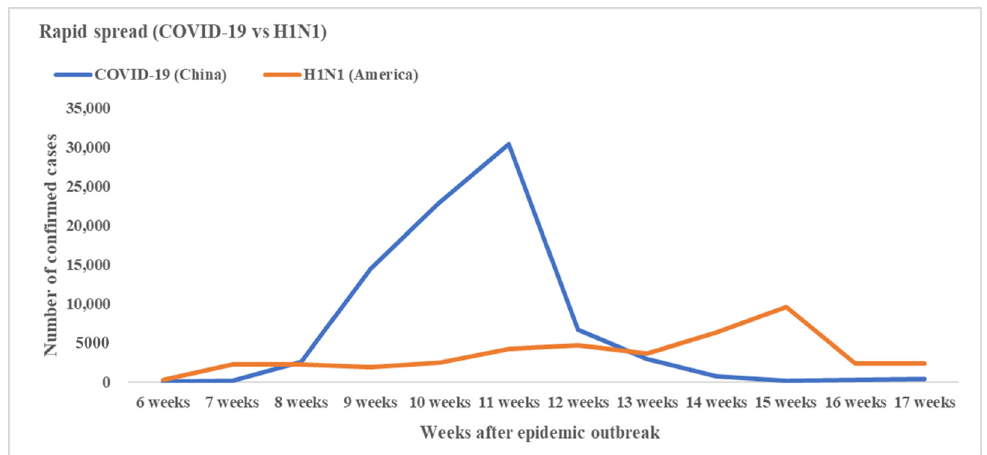
Figure 3. Number of total confirmed cases of COVID-19 in China and H1N1 in America the same time interval after the first emerged cases (by week).